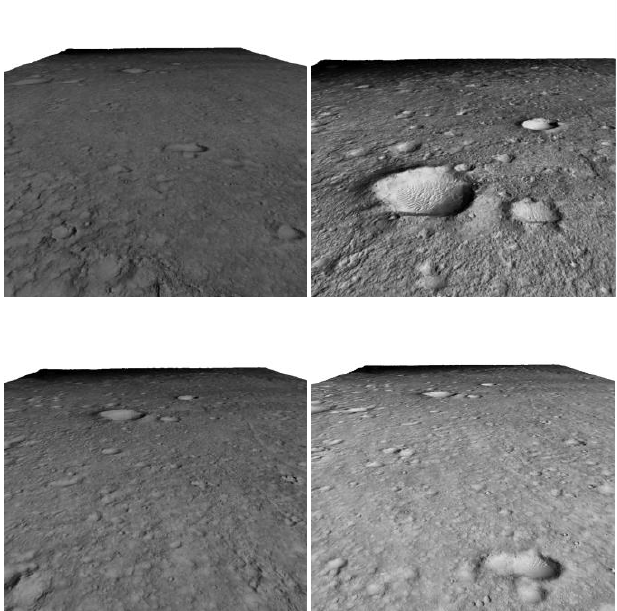
Figure 4. Samples of simulated